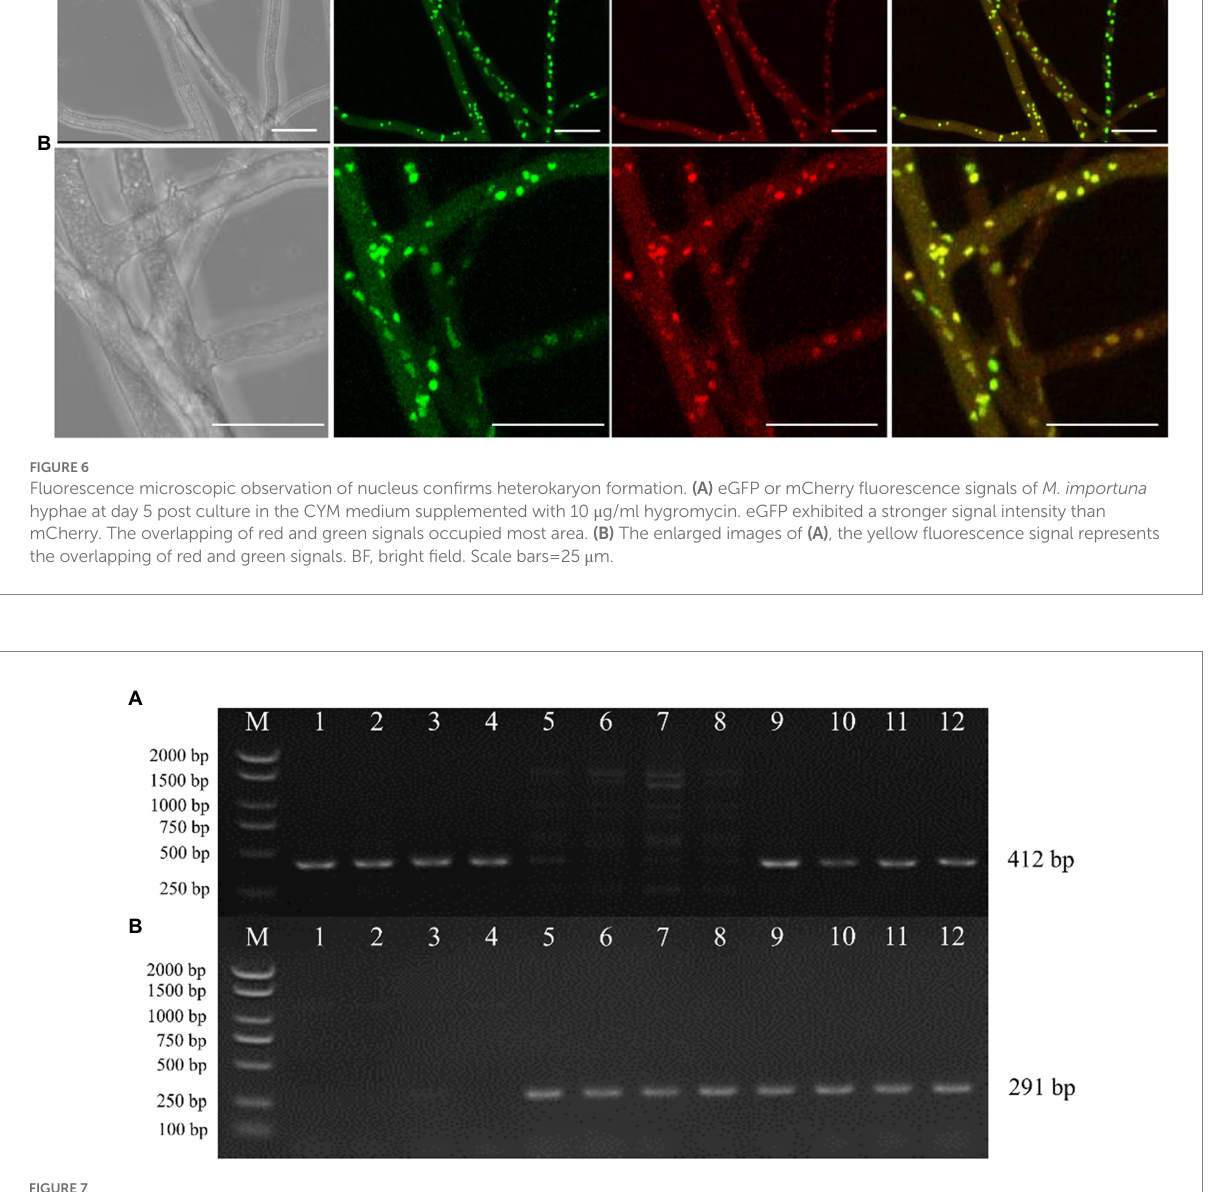
morel breeding development, we established two efficient fluorescent vectors with red and green fluorescence to label nuclei, and further used them for quickly and accurately screening stable